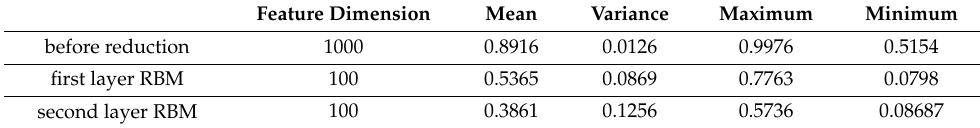
Table 1. Analysis of multispectral data before and after dimension